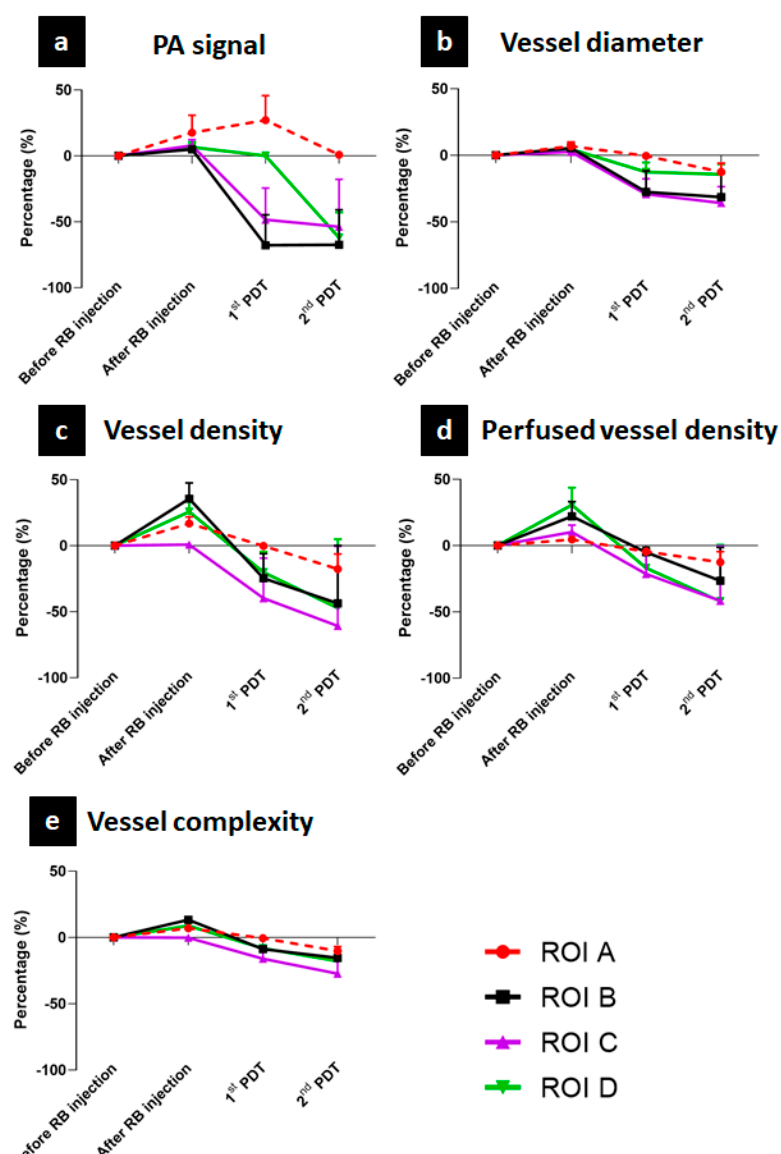
Figure 6. Quantitative evaluation results among ROI A (control vessel), ROI B (normal vessel), ROI C (melanoma 1), and ROI D (melanoma 2). ( a ) PA signal, ( b ) vessel diameter, ( c ) vessel density, ( d ) perfused vessel density, ( e ) vessel complexity.